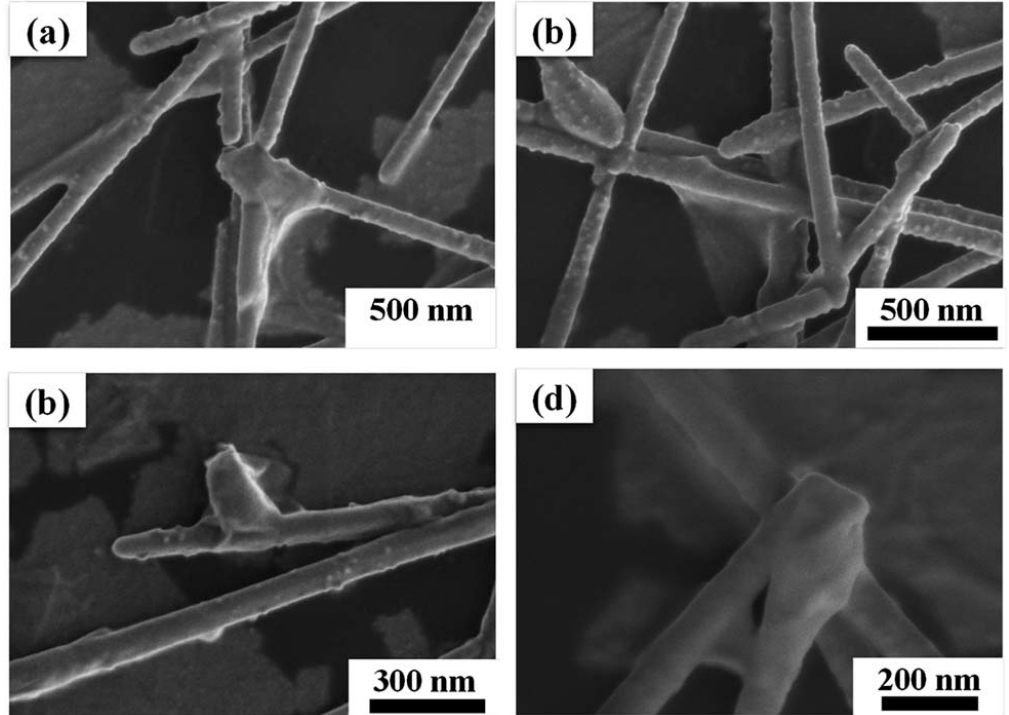
Figure 15. SEM images of RGO-coated silver nanowire networks after ( a ) 10,000, ( b ) 100,000, and ( c , d ) 800,000 bending cycles. Reproduced with permission from ref. [49] with permission from The Royal Society of Chemistry.